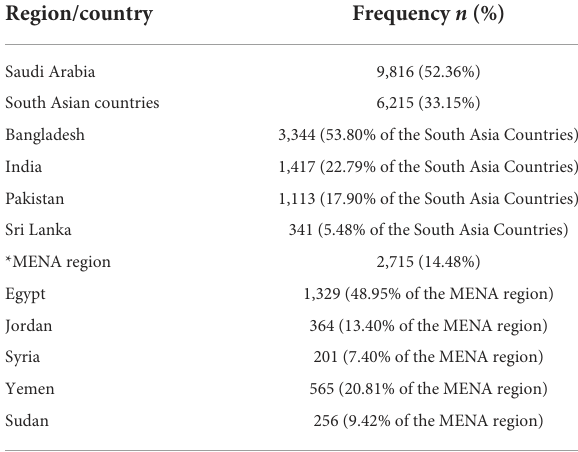
TABLE 2 Distribution of studied population according to the